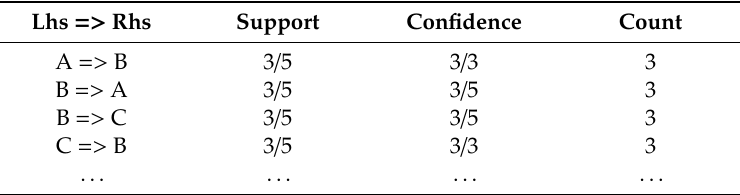
Table 2. Apriori Association